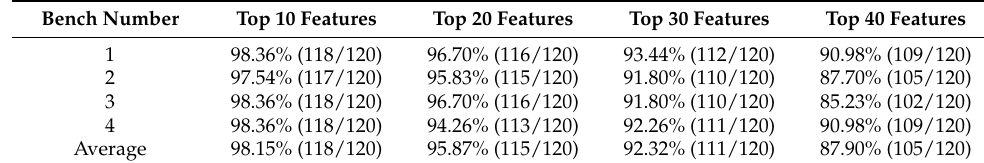
Table 6. Accuracy of different feature sets.